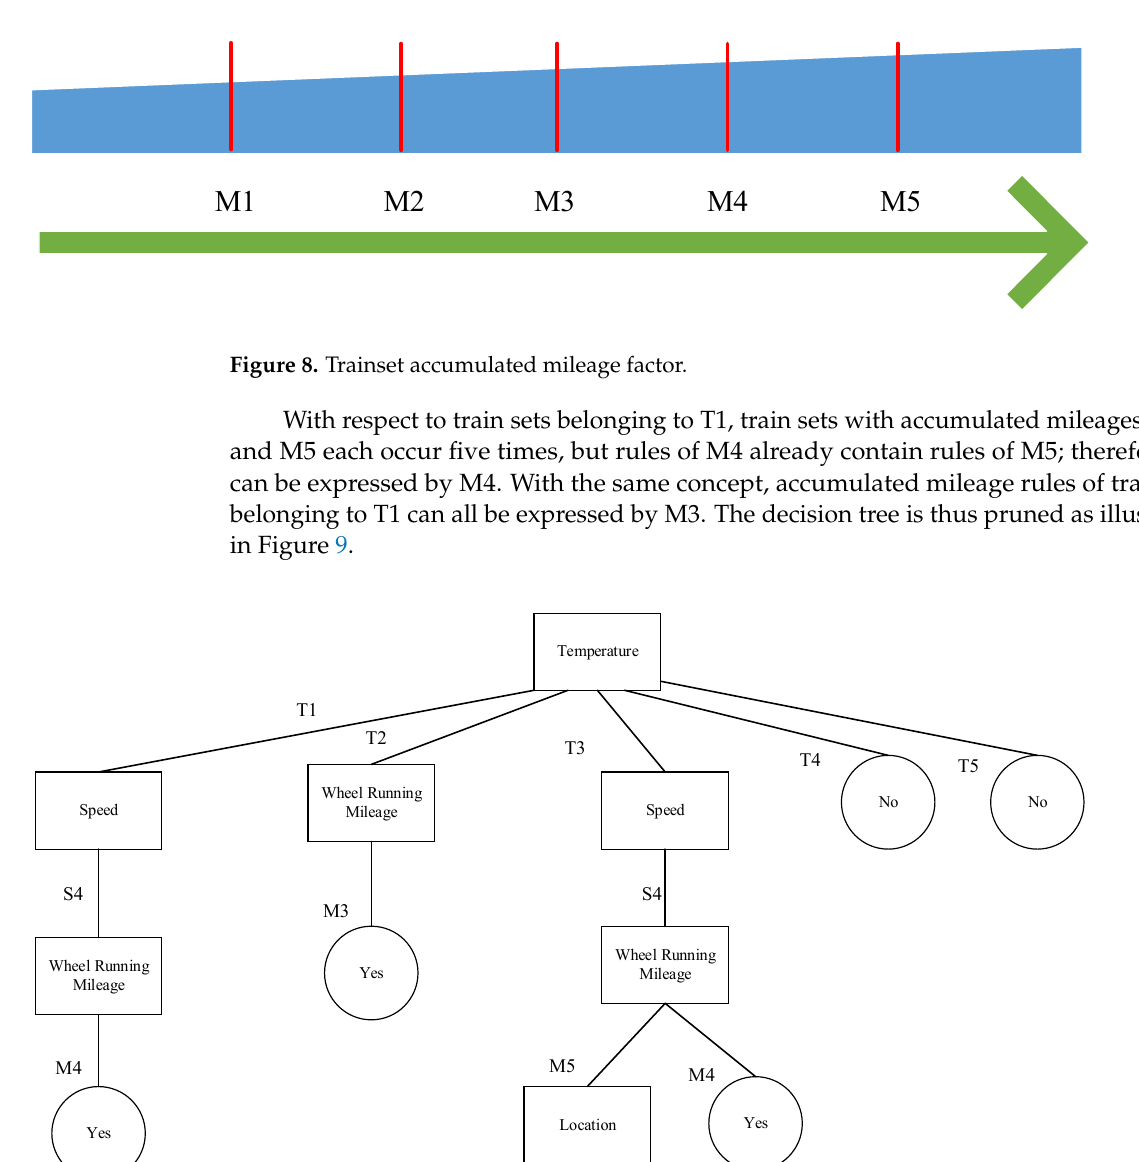
Figure 7. Ten analysis results of decision tree.